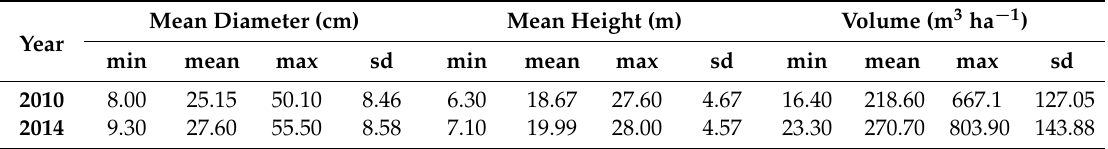
Table 1. Field data statistics for the variables of interest (based on 117 field